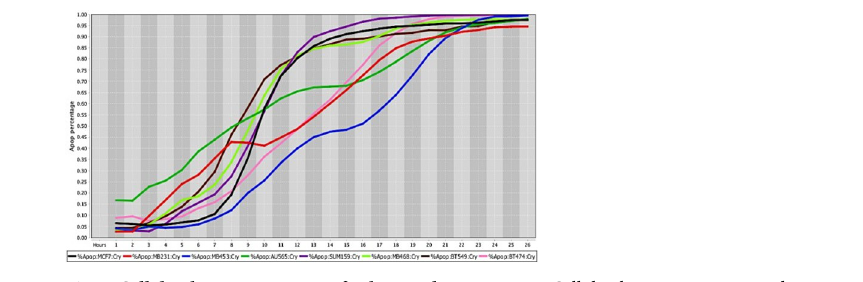
Fig 6. Cell death response curves for human breast cancer. Cell death response expressed in percentage of apoptosis in human breast cancer cell lines exposed to CT at 20 μ M concentration (MCF7- black line, MDA-MB-231- red line, MDA-MB-453- blue line, AU565- dark green line, SUM159- purple line, MDA- MB-468- neon green light, BT549- brown line, BT474- pink line).